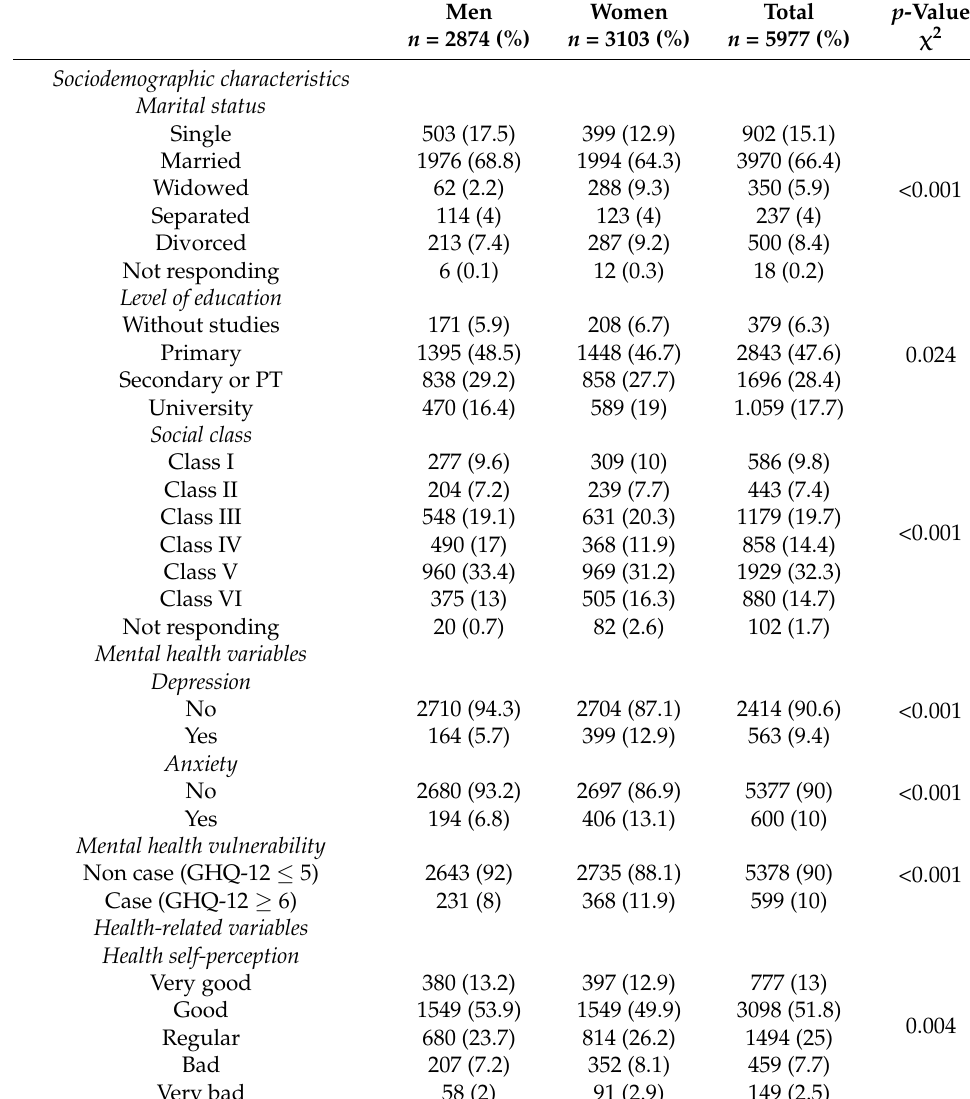
Table 1. Sociodemographic characteristics of Spanish pre-elderly (age between 50 and 64 years old) ( n = 5977).